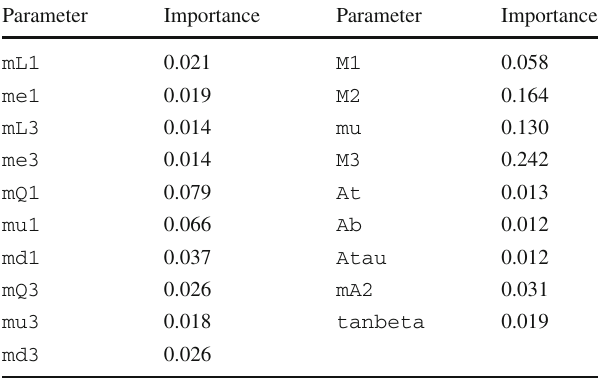
Table 5 Features’ importance for the trained RF classifier